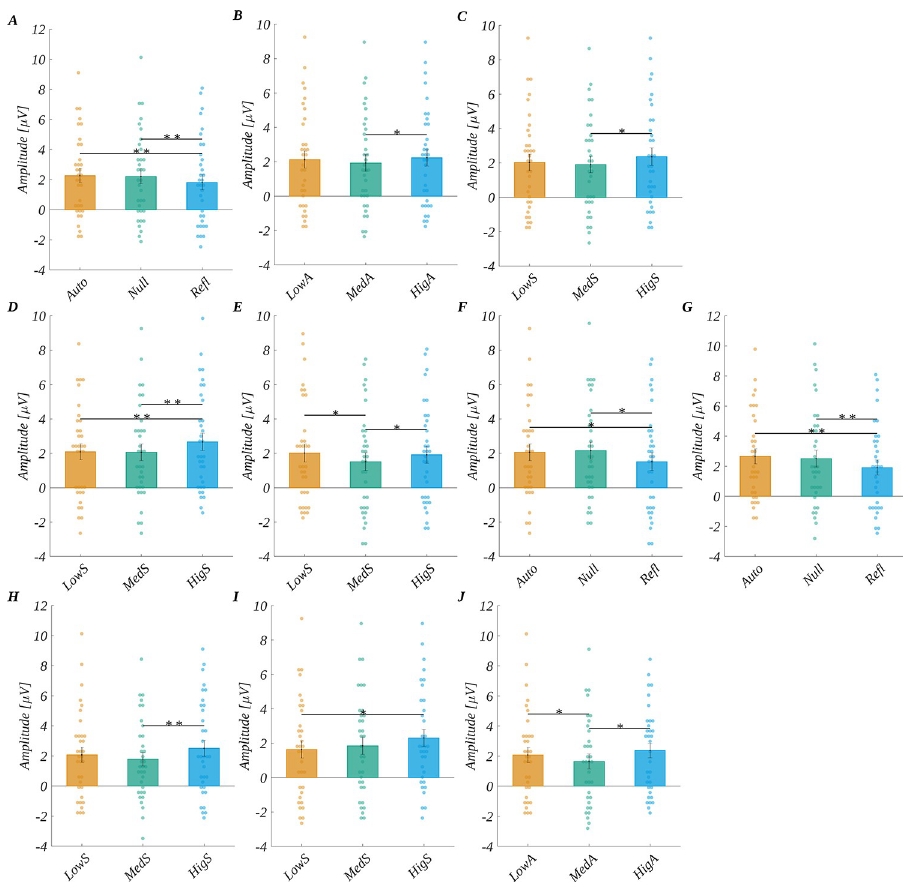
Fig 9. LPC results. The main effect obtained for LPC component (A) origin, (B) arousal, (C) subjective significance. Interaction between origin and subjective significance: amplitude dependence on subjective significance for (D) automatic and (E) reflective origin levels; dependence on origin for (F) medium significant and (G) highly significant stimuli. Interaction between arousal and subjective significance for different levels of subjective significance at (H) low arousal and (I) medium arousal; dependence of the amplitude on arousal for low significant words (J). Bars represent the mean value, error bars SEM, individual dots mark the amplitude for an individual subject in the given condition, black horizontal lines indicate pairs of conditions with significantly different means ( � p < 0.05, �� p <